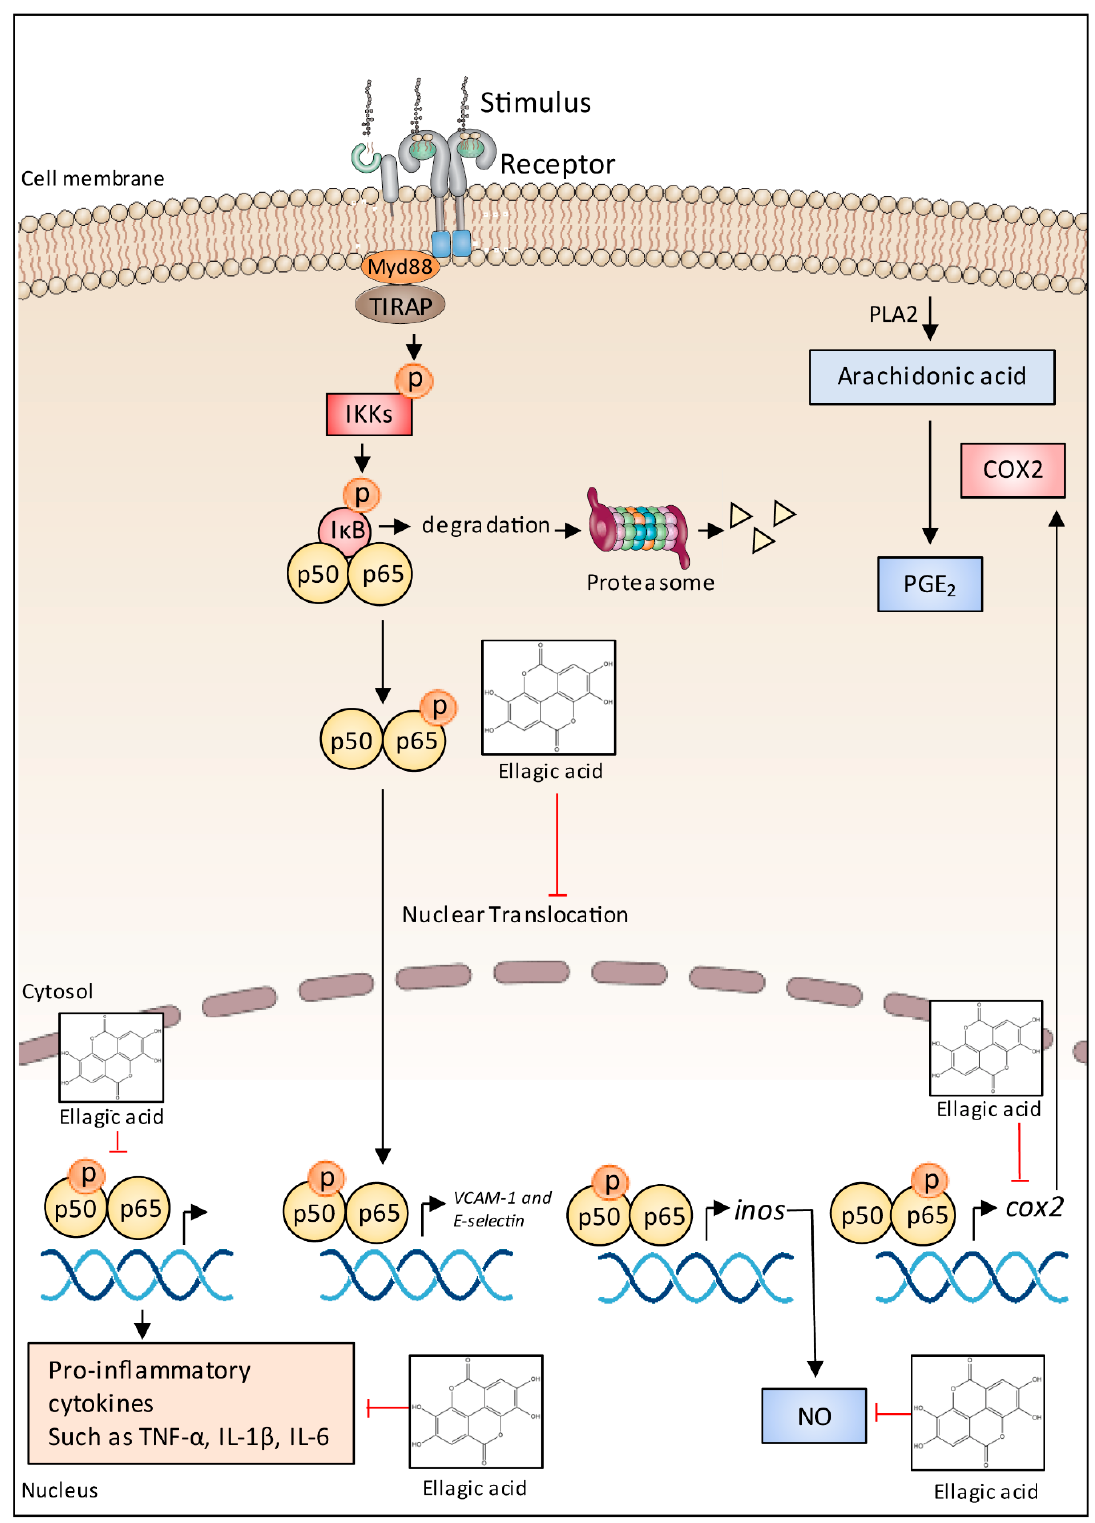
Figure 6. Anti-inflammatory mechanisms of ellagic acid. Triangles represent degraded IkB.